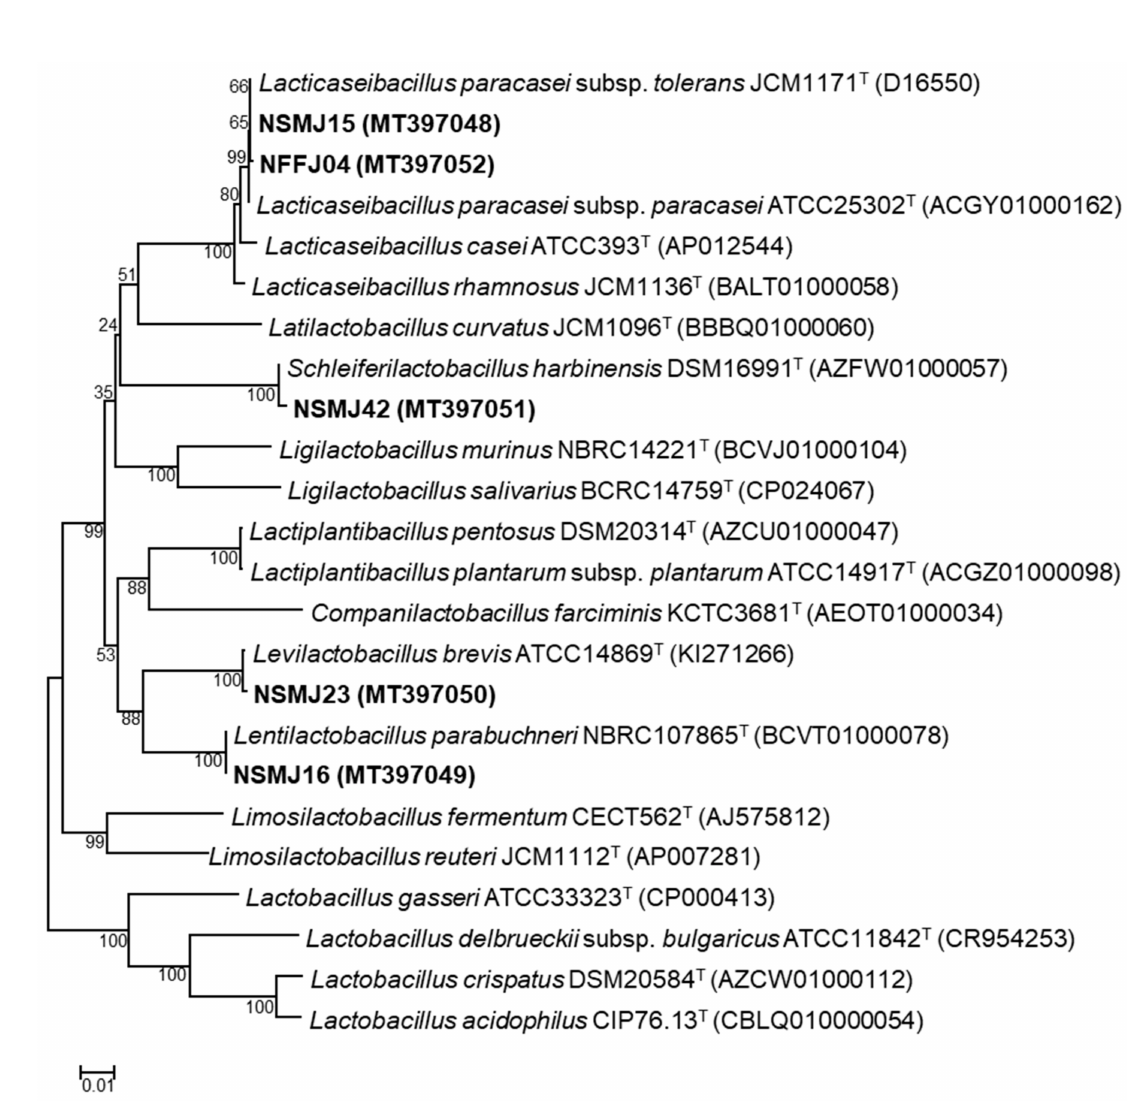
Figure 1. Phylogenetic analysis of five selected lactic acid bacteria (LAB) strains based on their 16S rRNA gene sequences. Bacillus subtilis subsp. subtilis NCIB3610 T was used as an outgroup (not shown). The scale bar indicates the number of changes per nucleotide